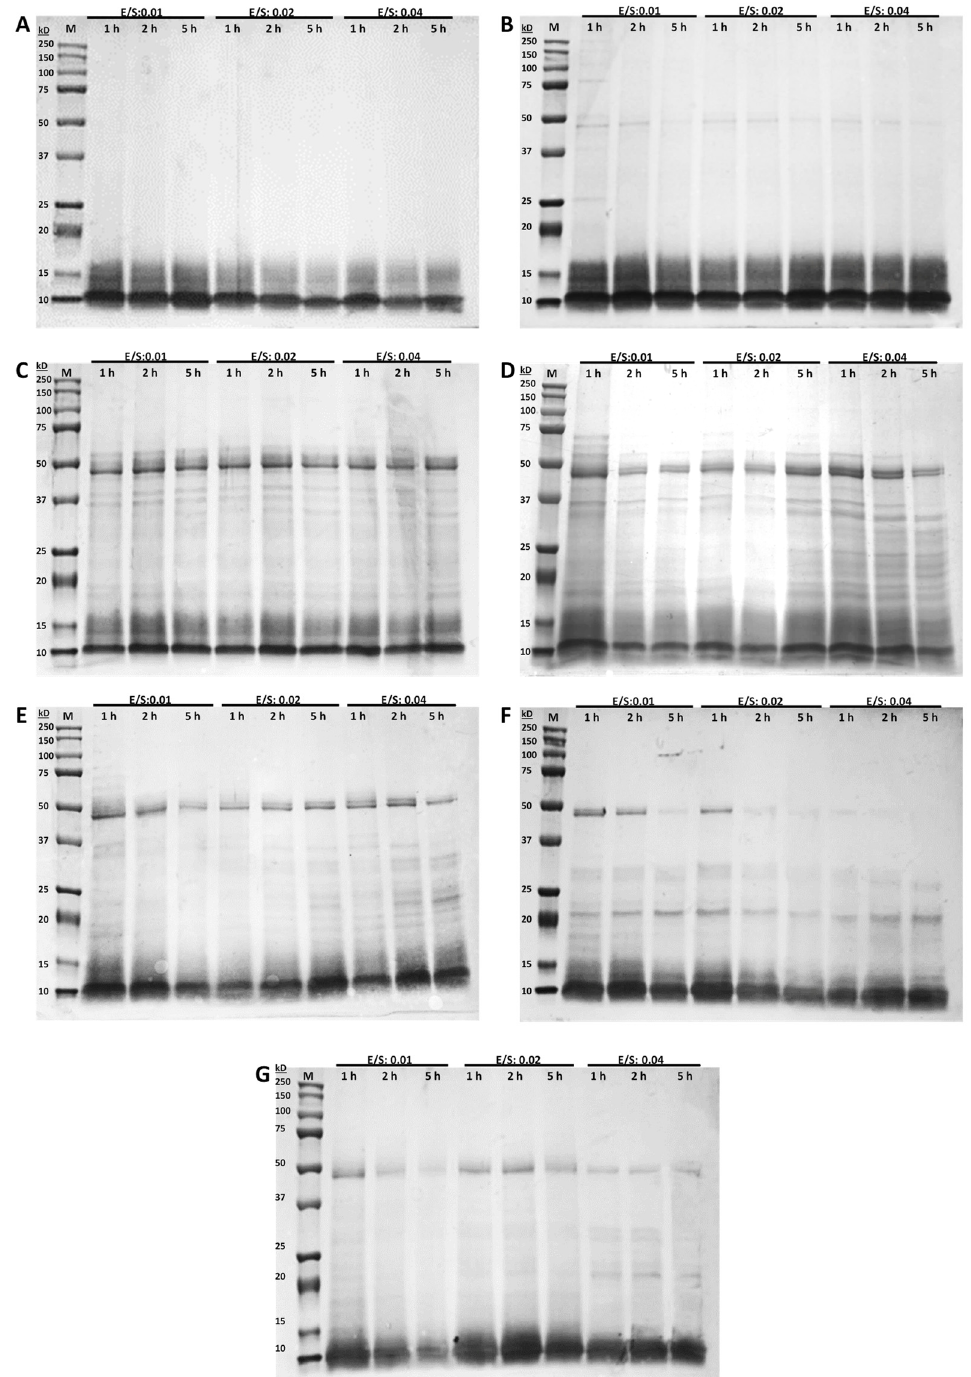
Figure 2. Molecular weight (kD) profiles of LPI hydrolysates by different commercial proteases at different E/S ratios and hydrolysis times as determined by SDS-PAGE under reducing conditions.